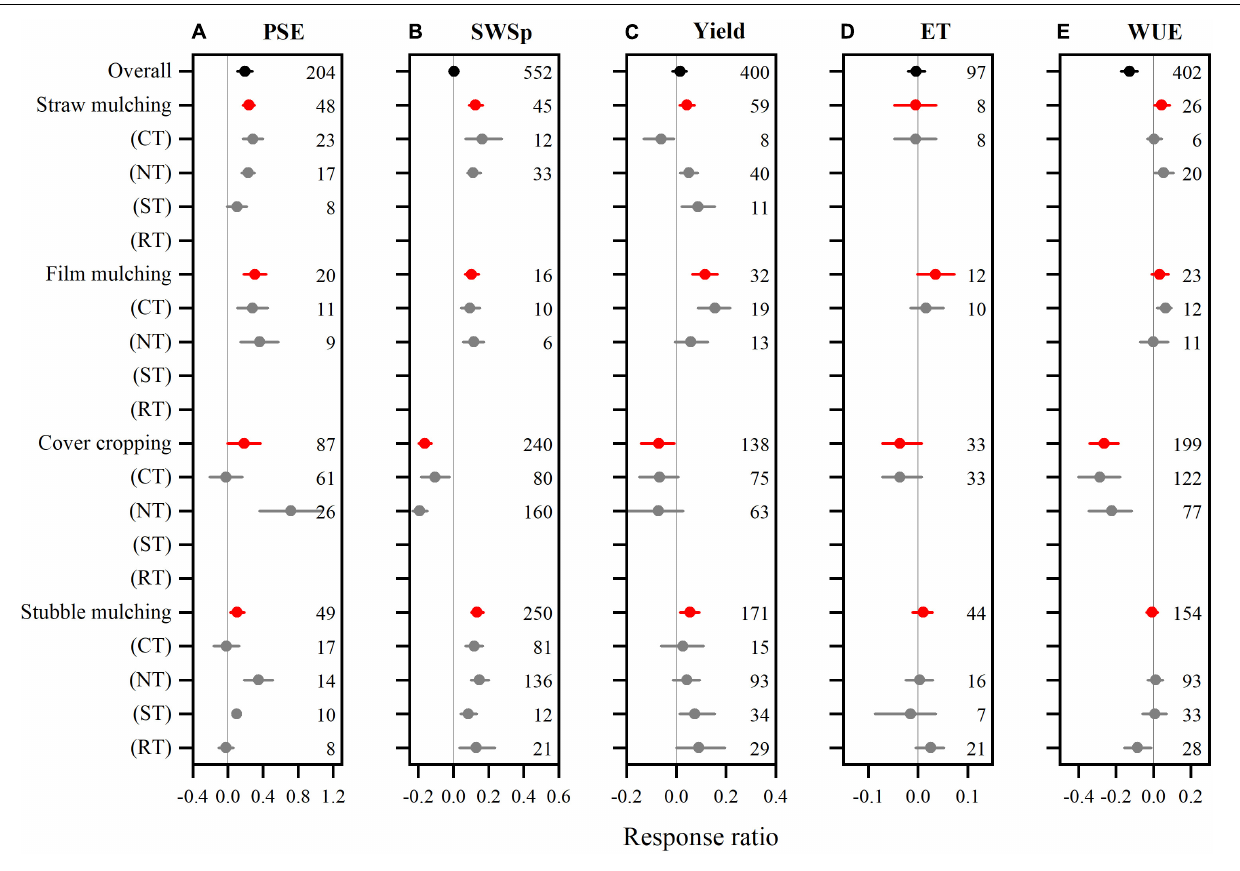
FIGURE 4 | The mean response ratios of precipitation storage efficiency (PSE, A ), soil water storage at wheat planting (SWSp, B ), winter wheat grain yield (C) , evapotranspiration (ET, D ), and water use efficiency (WUE, E ) to fallow mulching practices compared to no mulching and their interactions with tillage methods. The horizontal line represents the bootstrapped 95% confidence interval. Conservation tillage methods are no tillage (NT), reduced tillage (RT), subsoil tillage (ST). The reference line (RR = 0) specifies no variation between conservation tillage and conventional tillage. Numbers accompanying the bootstrapped 95% confidence intervals designate the number of observations for